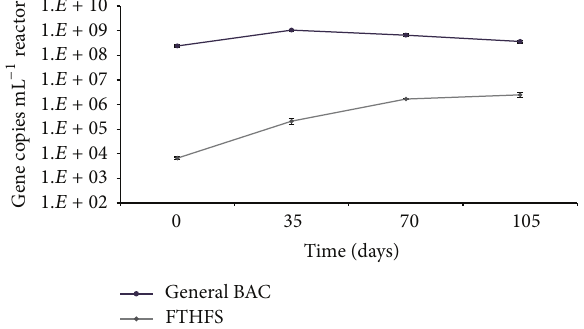
Figure 5: Gene copies for General Bacteria (BAC) and the FTHFS gene (marker of homoacetogens) over the duration of operation of the semicontinuous